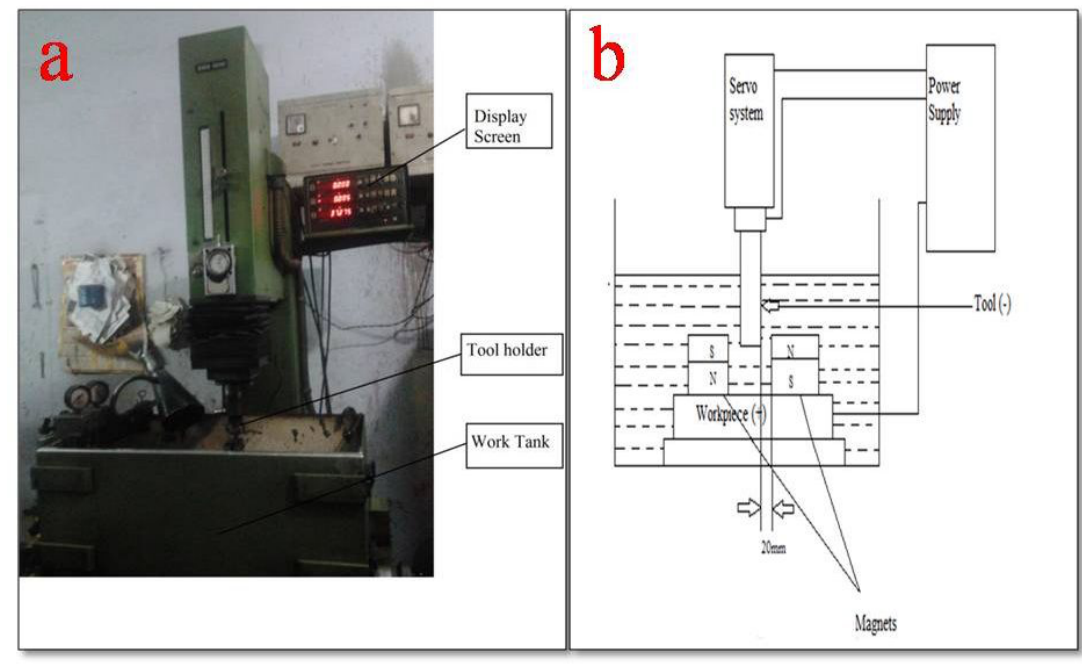
Figure 1: (a) Die sink EDM set-up; (b) Schematic diagram of magnetic Force assisted EDM